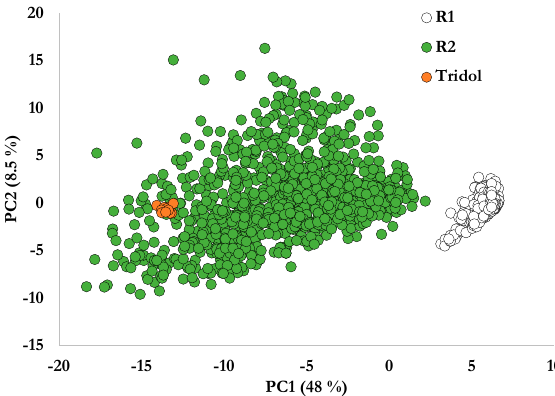
Figure 8. Scores plot for the first two principal components for a PCA conducted on Raman spectra (after baseline correction and SNV) obtained from measurements in reactors 1 and 2 during the biodegradation process of Tridol S3B, and Raman spectra of pure Tridol S3B.